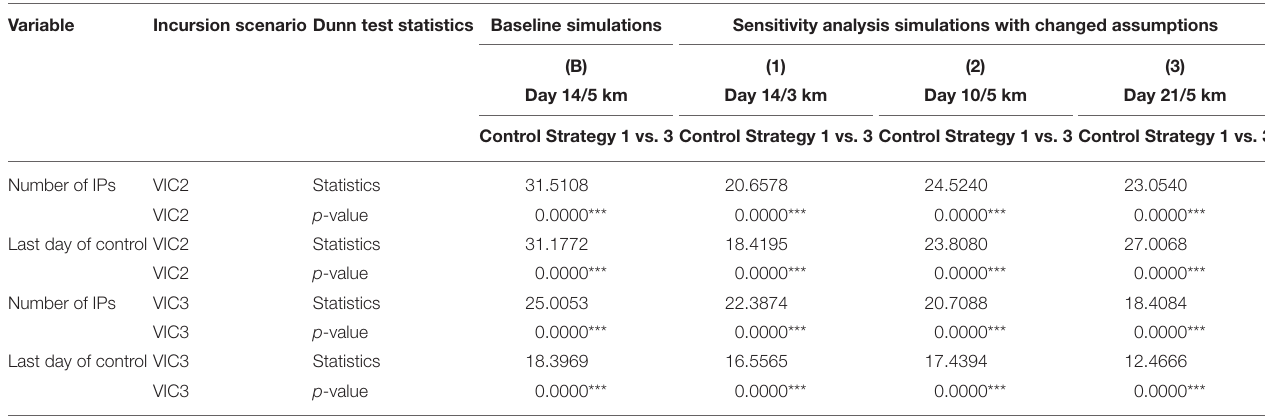
TABLE 10 | Dunn tests for sensitivity analyses—comparisons of Control Strategy 1 with Control Strategy 3 for baseline simulation assumptions and changed vaccination assumptions for sensitivity analysis. Variable Incursion scenario Dunn test statistics Baseline simulations Sensitivity analysis simulations with changed